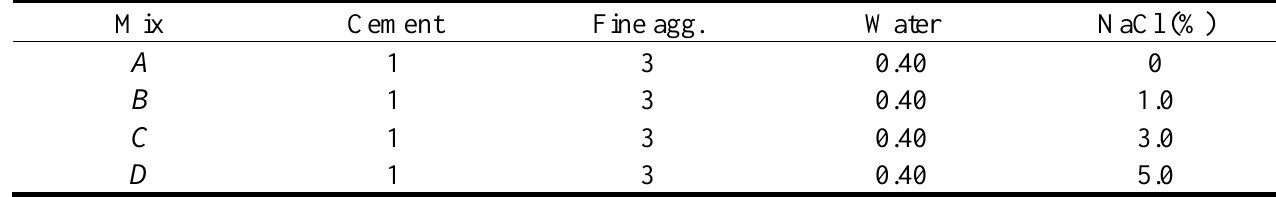
Table 3. Mixture proportions of the cement mortar specimens used in this study.